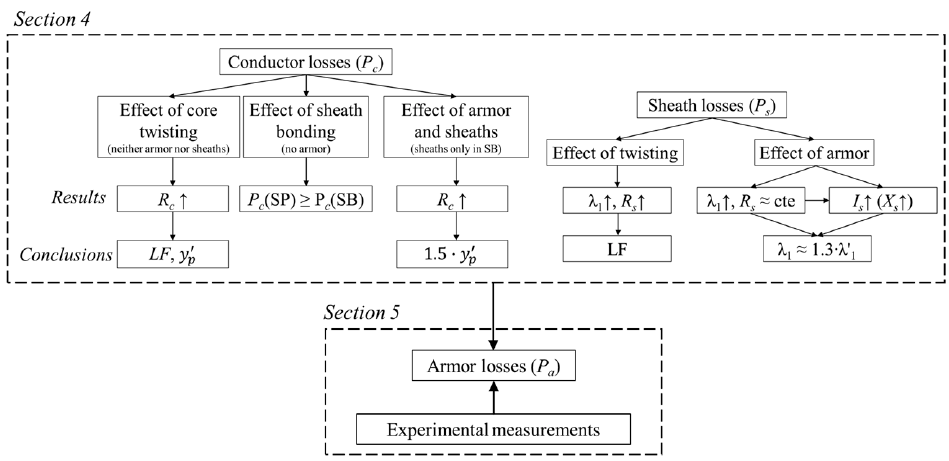
Figure 20. Main results and conclusions derived from Section 4 regarding P c and P s , and their use as inputs for improving the experimental evaluation of P a proposed in Section 5.